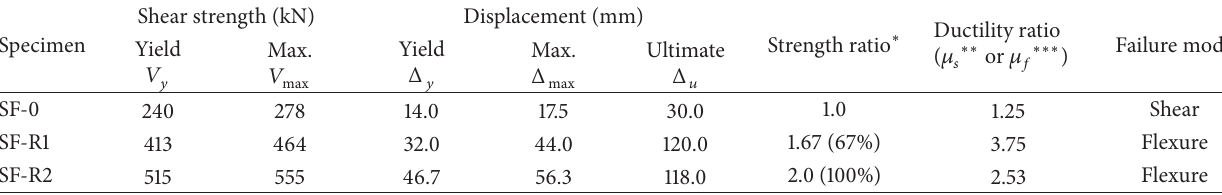
Table 9: A summary of the strength and deformation capacities of the test specimens.